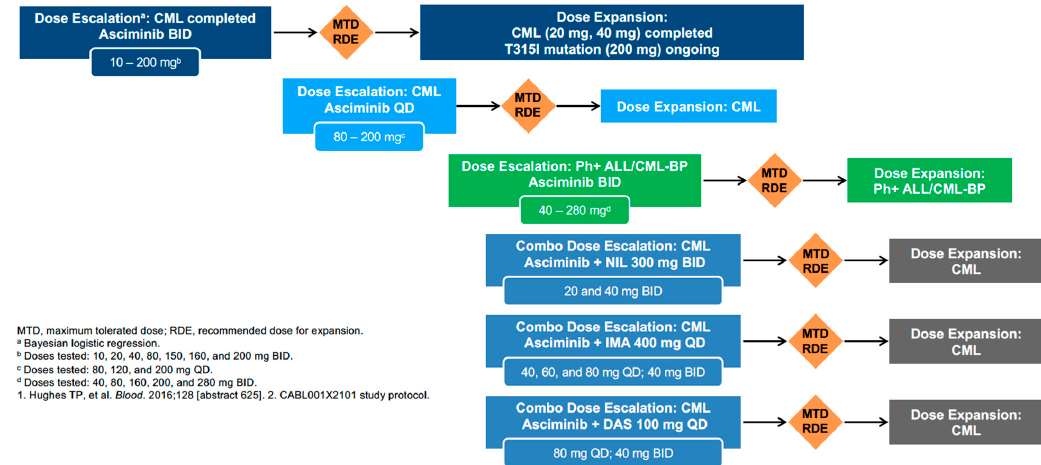
Figure 4. Phase 1 FIH study: single agent in CML/ALL and combinations in combinations in CML (CABL001 × 2101). NIL = nilotinib ; BID = twice a day; QD = once a day; MTD: maximum tolerated dose; RDE: recommended dose for expansion.